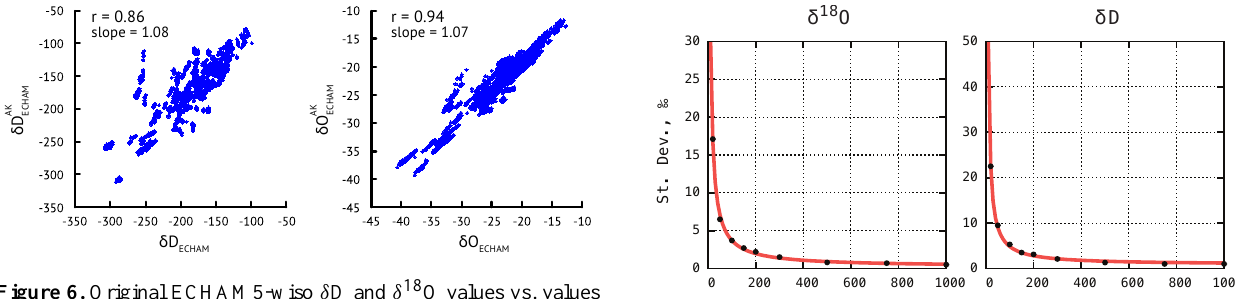
Figure 6. Original ECHAM5-wiso δ D and δ 18 O values vs. values smoothed by applying the column averaging kernels to the model results. Figure 7. Precision of the retrieval as a function of the signal-to- noise ratio of the